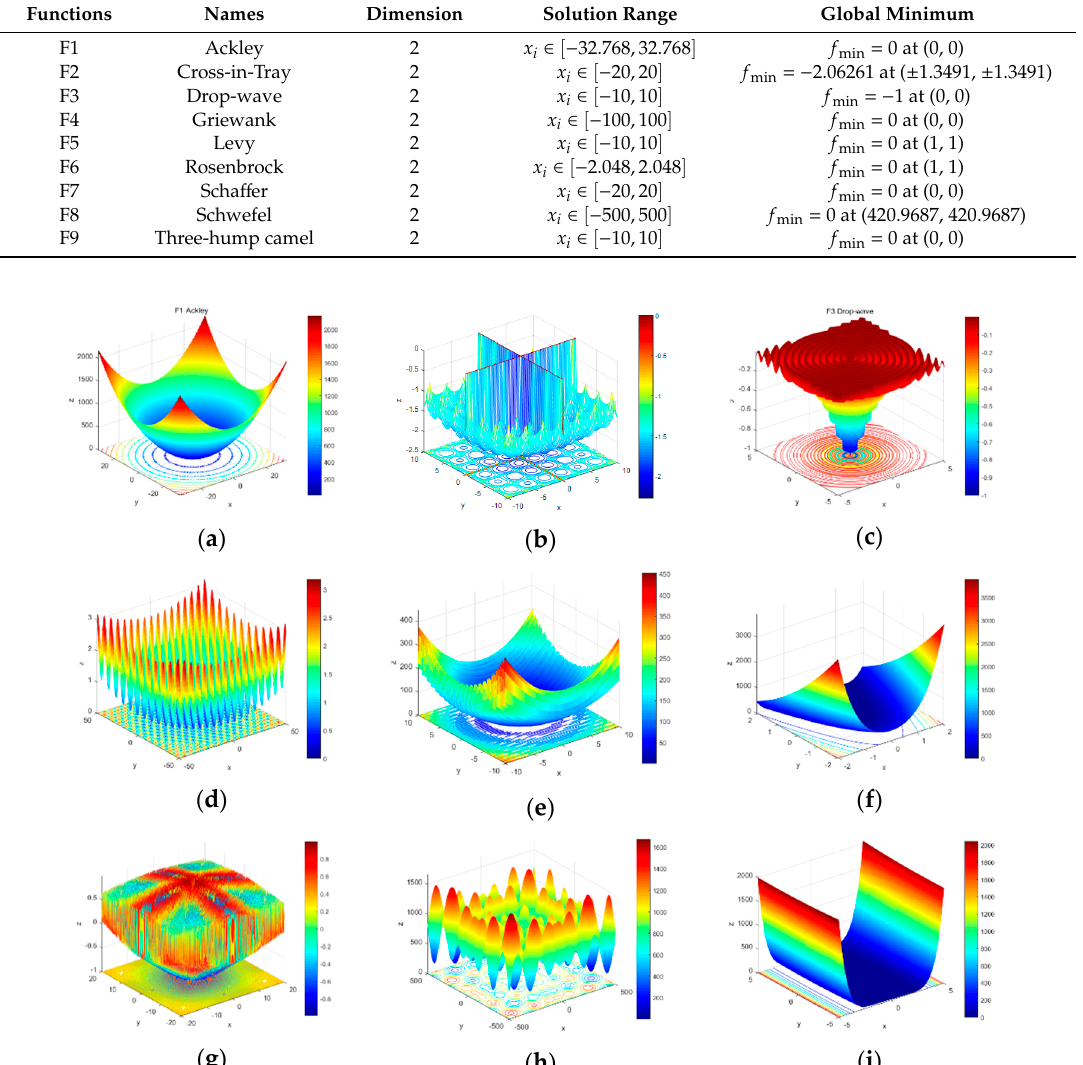
Table A1. Two-dimensional benchmark test functions considered in the simulations.